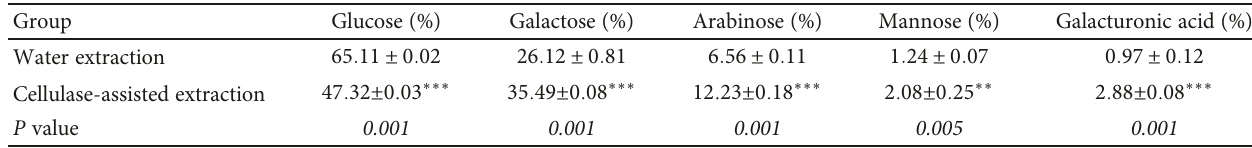
Table 2: Monosaccharide composition of Astragalus polysaccharides extracted by di ff erent methods.